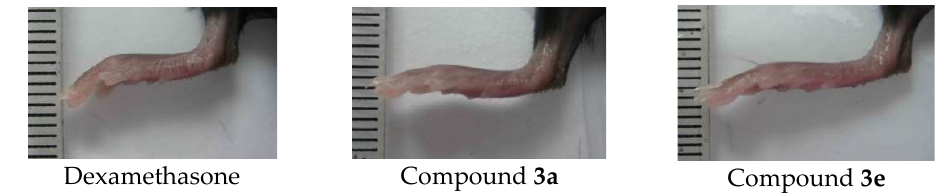
Figure 2. Shape of the mouse foot. Zymosan A-induced infiltration of inflammatory cells and edema was observed after the injection of zymosan A (VH) on the right footpad.